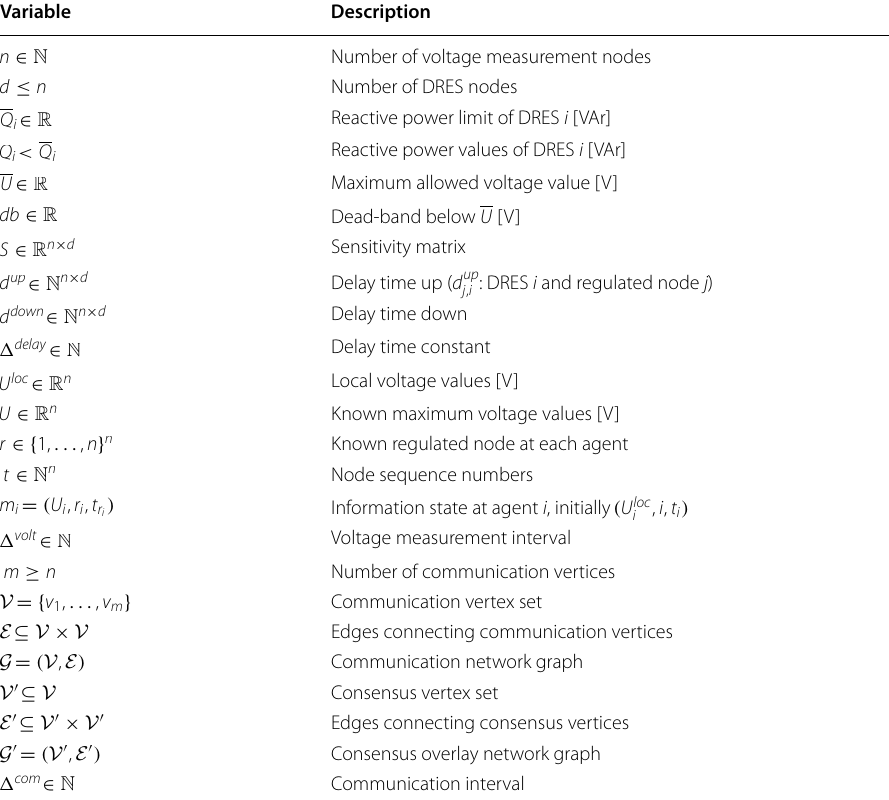
Table 1 Overview of voltage regulation, max-consensus and communication network variables Variable Description Number of voltage measurement